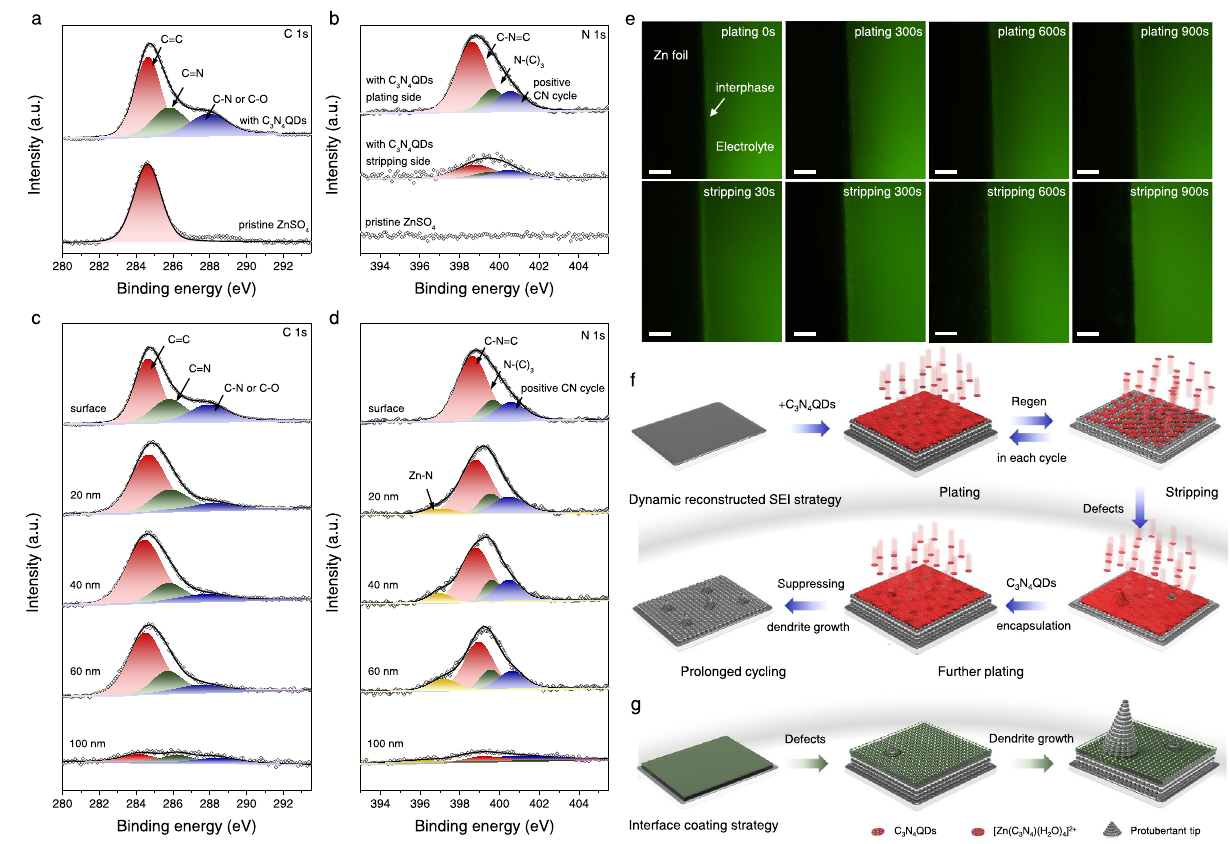
Fig. 3 | The real-time reconstructedprotective interphase regenerated in each cycle. High-resolutionXPSanalyzationofthe a C1s,and b N1speaksobtainedfrom the Zn anode after 15th stripping/plating process under the current density of 1mAcm -2 and capacity of 1mAhcm − 2 in 2M ZnSO 4 +0.5mgmL − 1 C 3 N 4 QDs elec- trolyte (topspectrum)and 2M ZnSO 4 electrolyte (bottom spectrum); c , d the XPS